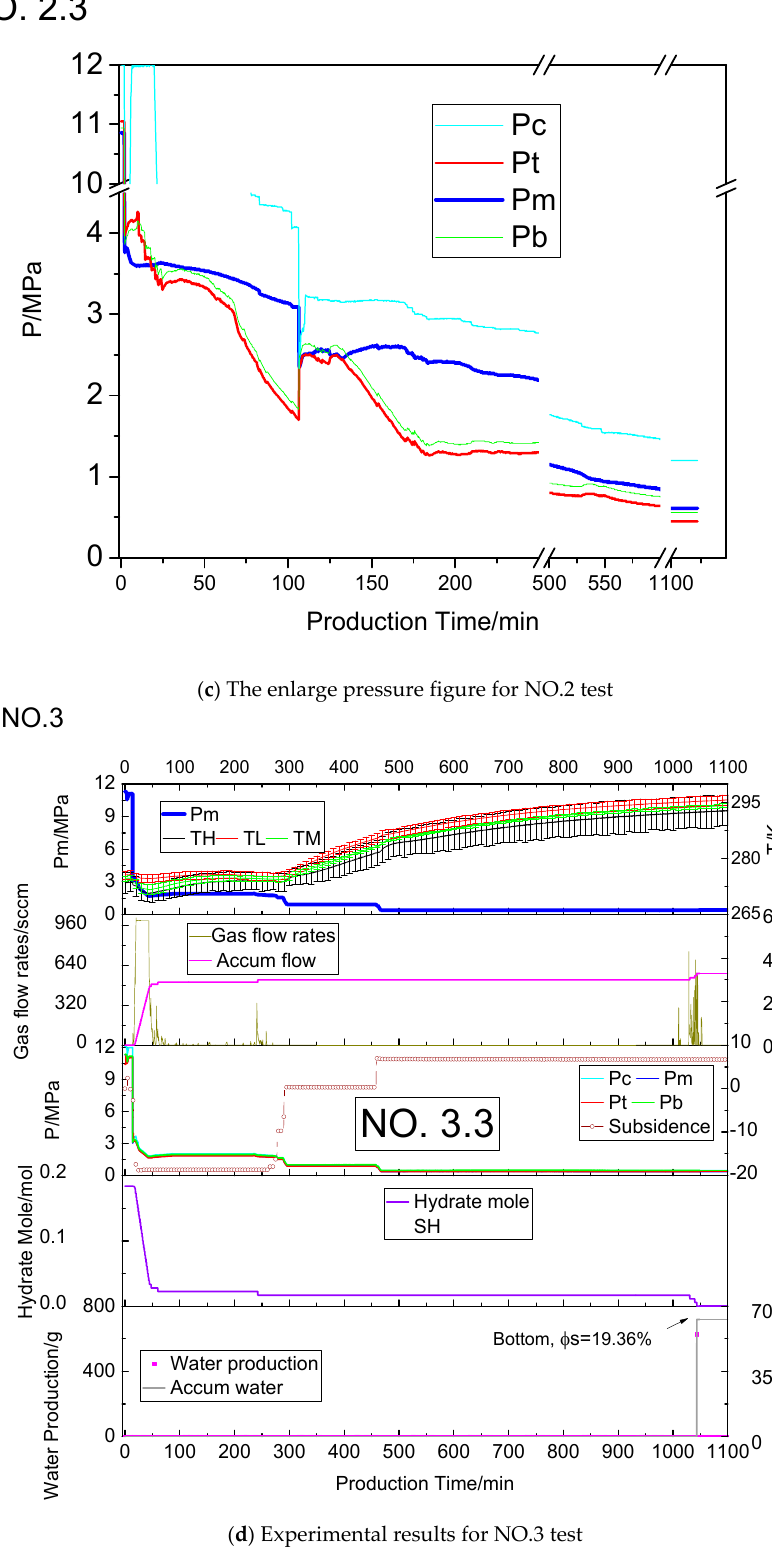
( d ) Experimental results for NO.3 test Figure 4.